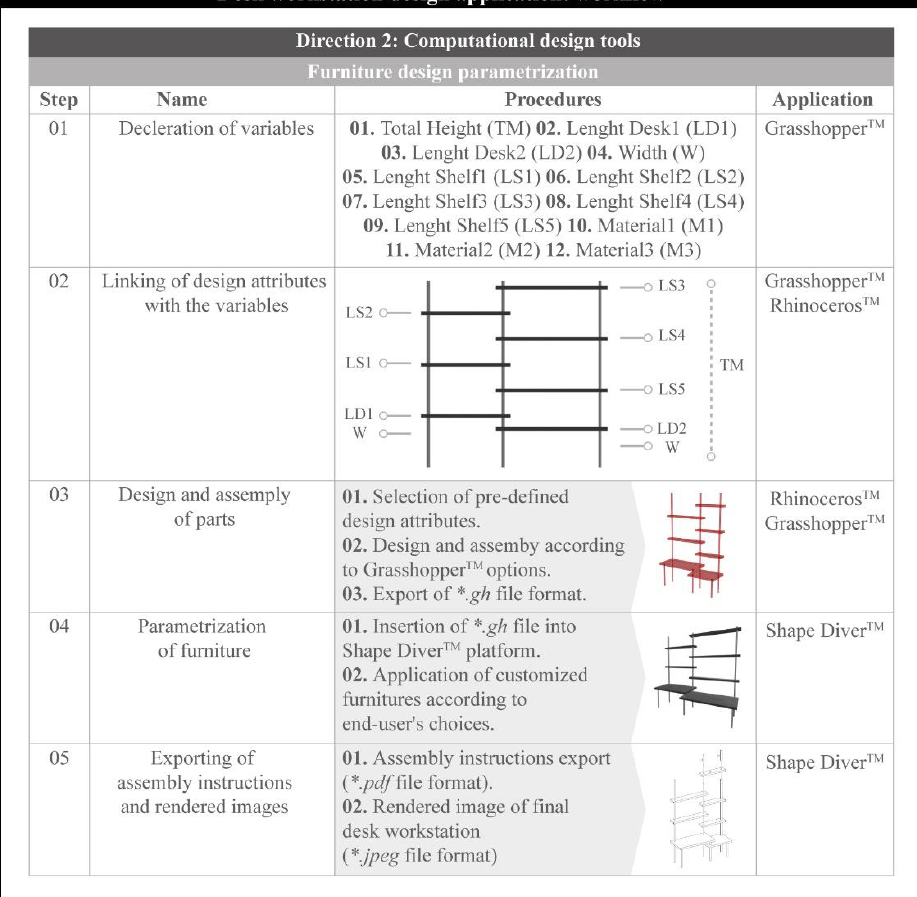
Figure 9. Workflow of the desk workstation design application.